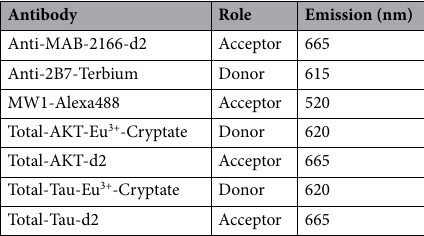
Table 3. Antibodies used in HTRF assays.